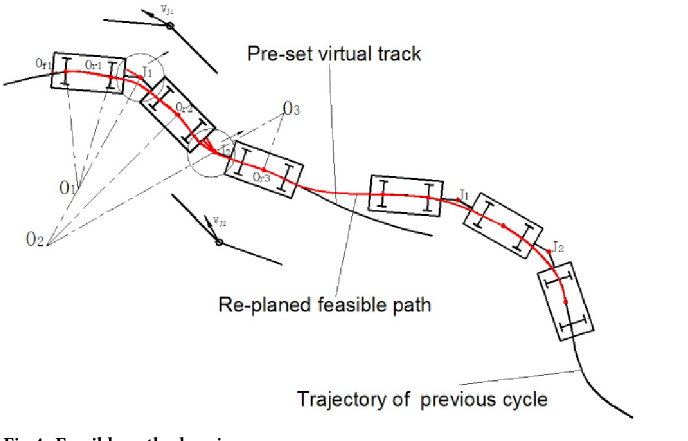
Fig 4. Feasible path